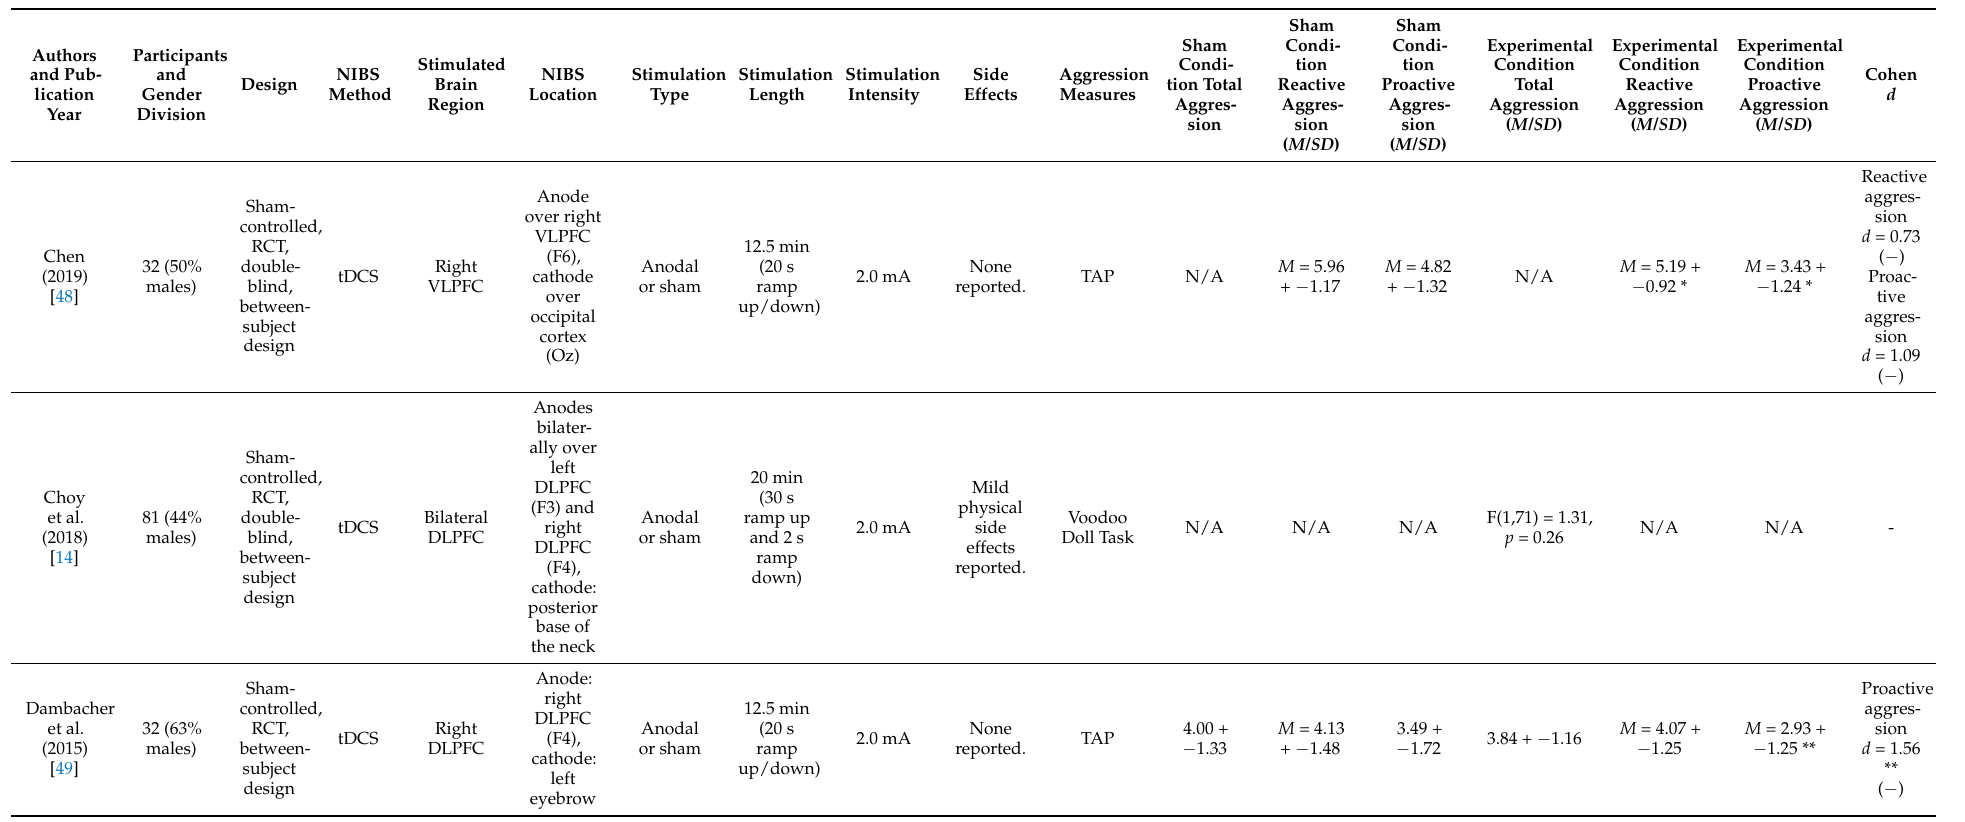
Table 1. Overview for each study of the methodology and